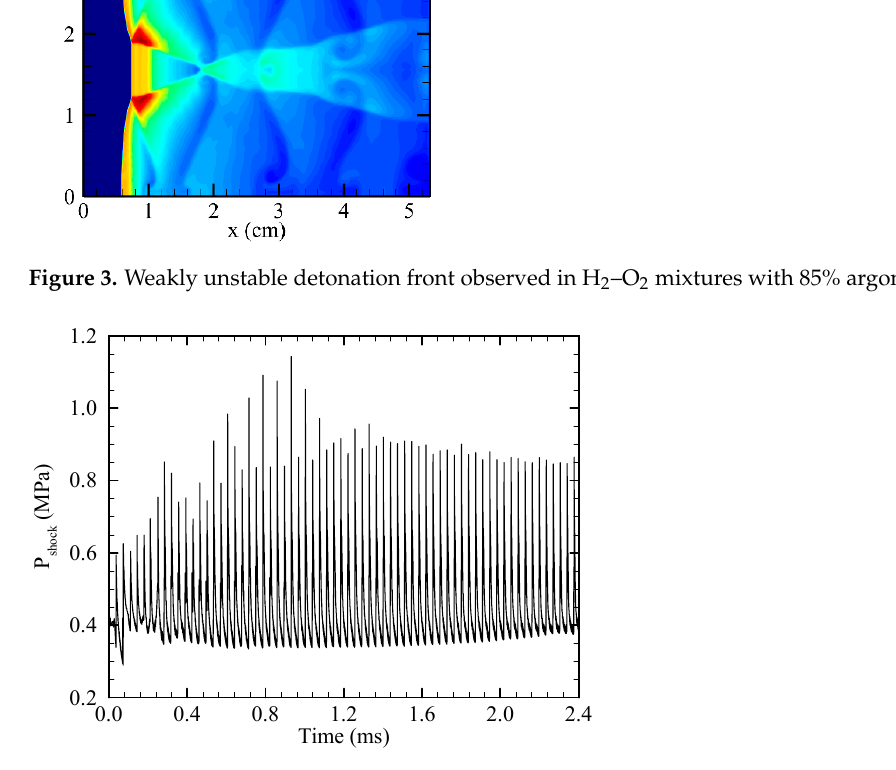
Figure 4. Post shock pressure traced along the centerline for weakly unstable detonation case with 2H 2 + O 2 + 17Ar mixture.